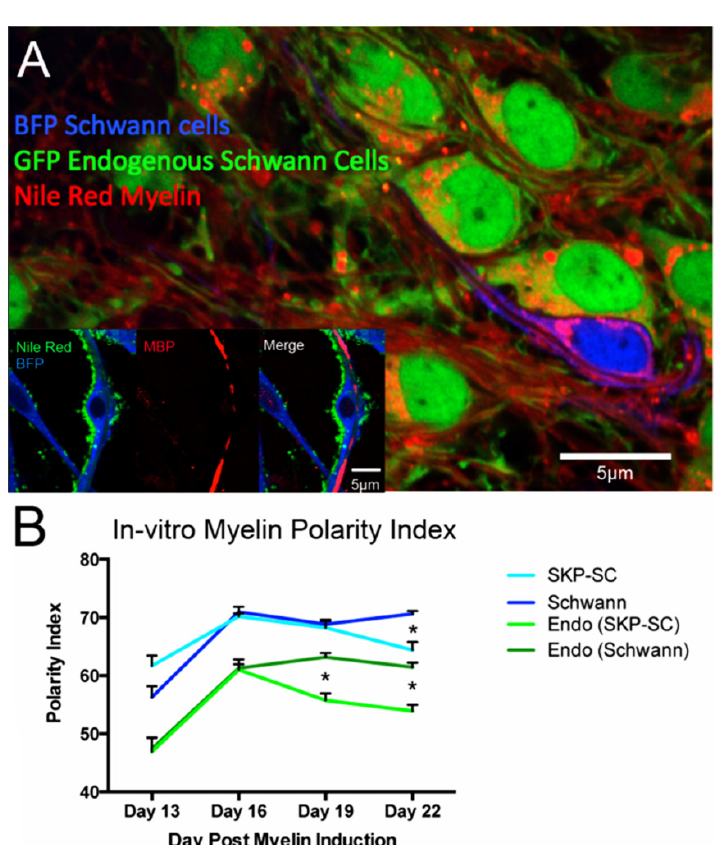
Figure 4. Spectral analysis of an in-vitro co-culture system of GFP expressing DRGs and Schwann cells, co-cultured with either BFP expressing SKP-SCs or Schwann cells. ( A ) BFP (transplanted) Schwann cells and GFP (endogenous) Schwann cells myelinate in live culture after myelination was induced by ascorbic acid (Image at 19 days post-induction of myelination). Inset: Post-fixation, SKP-SCs demonstrate MBP positive myelin (Image at 16 days after myelin induction. 3-channel unmix (blue = BFP, green = Nile red, Red = MBP / Alexa555). Of note, e ff ective tissue processing for MBP staining involves detergent exposure, and hence formation of lipid rich Nile Red positive micelles that accumulate on the SKP-SC border. However, Nile Red stained myelin and MBP still co-localize to the expected location of the myelin sheath. ( B ) Averaged Peak Polarity index of in-vitro myelin selection regions from transplanted BFP + ve Schwann and SKP-SCs, as well as the endogenous Schwann cell populations of those respective conditions (Endo-SKP,